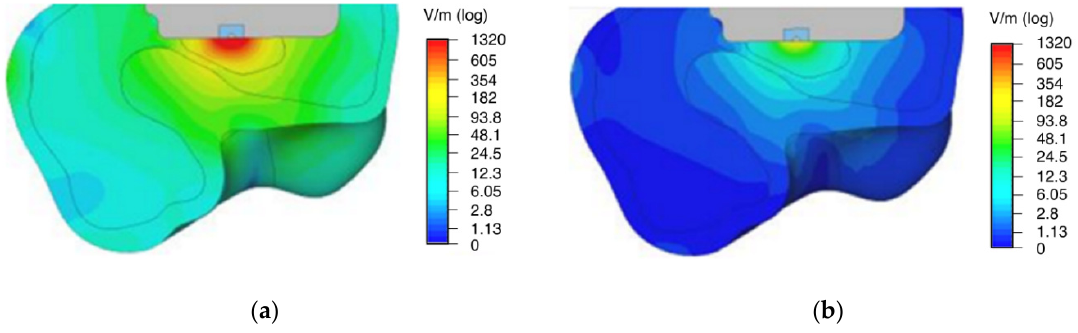
Figure 5. Electric field distribution obtained for case study 3. A voltage of ( a ) 6.0 V and ( b ) 0.2 V was applied at 20 Hz, representing clinical conditions.